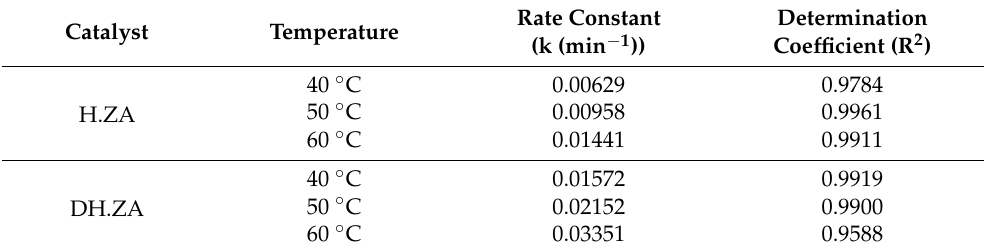
Figure 7. Fitting of the transesterification results by H.ZA and DH.ZA with the pseudo-first-order kinetic model ( A , B ), fitting of the transesterification results with Arrhenius equation ( C ), and fitting of the transesterification results with Eyring – Polanyi equation ( D ). Table 3. The values of the determined determination coefficient and rate constant values of the transesterification reactions by both H.ZA and DH.ZA as fitting parameters of pseudo-first-order kinetic model.